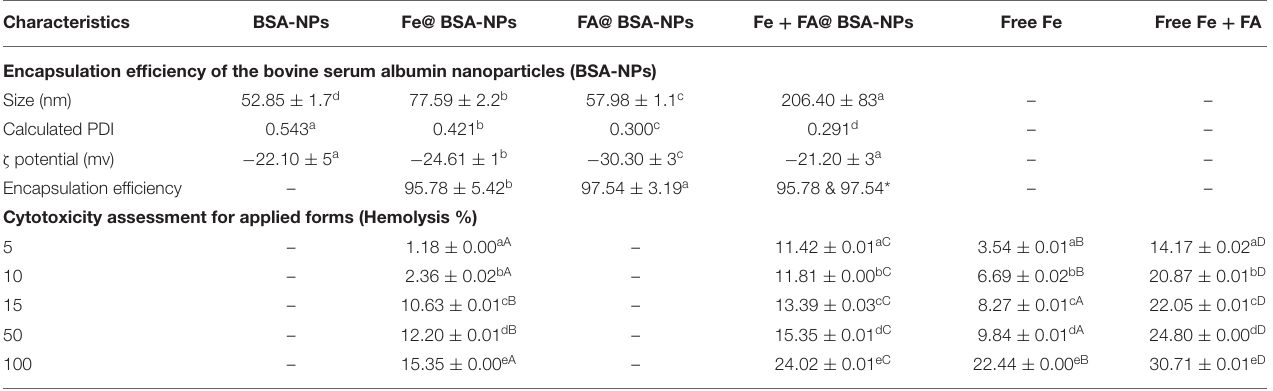
TABLE 1 | Characterization of the bovine serum albumin nanoparticles (BSA-NPs). Characteristics